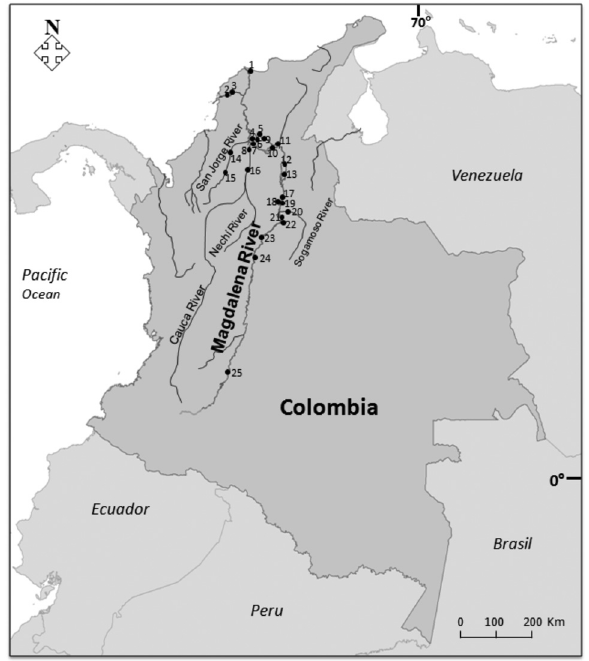
Figure 1 - Sampling sites in the Magdalena River basin and its tributar- ies-Colombia. 1) Ciénaga Grande de Santa Marta lagoon; 2) Gambote; 3) Mahates; 4) Pajarales lagoon; 5) Pijiño lagoon; 6) Guacamayal lagoon; 7) Palomino;8)SantaPaula;9)Mompos;10)Barrancodeloba;11)Zapatosa lagoon; 12) La Gloria; 13) Gamarra; 14) San Benito de Abad; 15) San Marcos; 16) Cauca River; 17) Puerto Wilches; 18) Canta Gallo